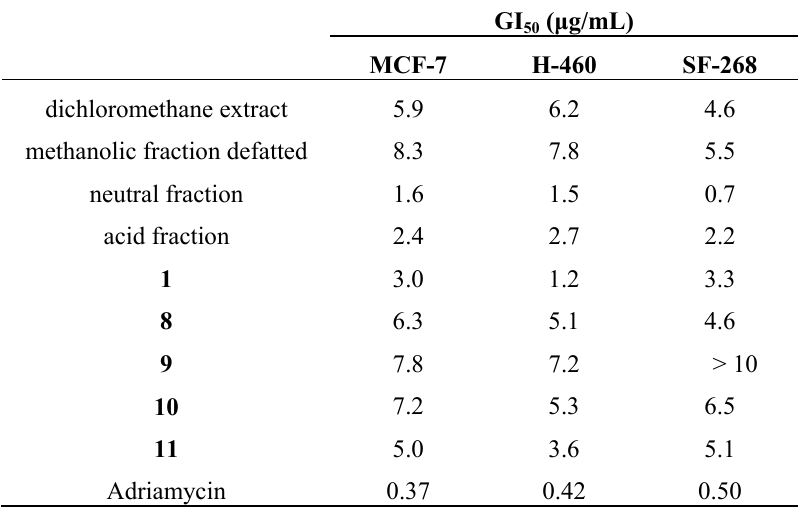
Table 1 . Antineoplastic cytotoxicity of extracts and compounds 1,